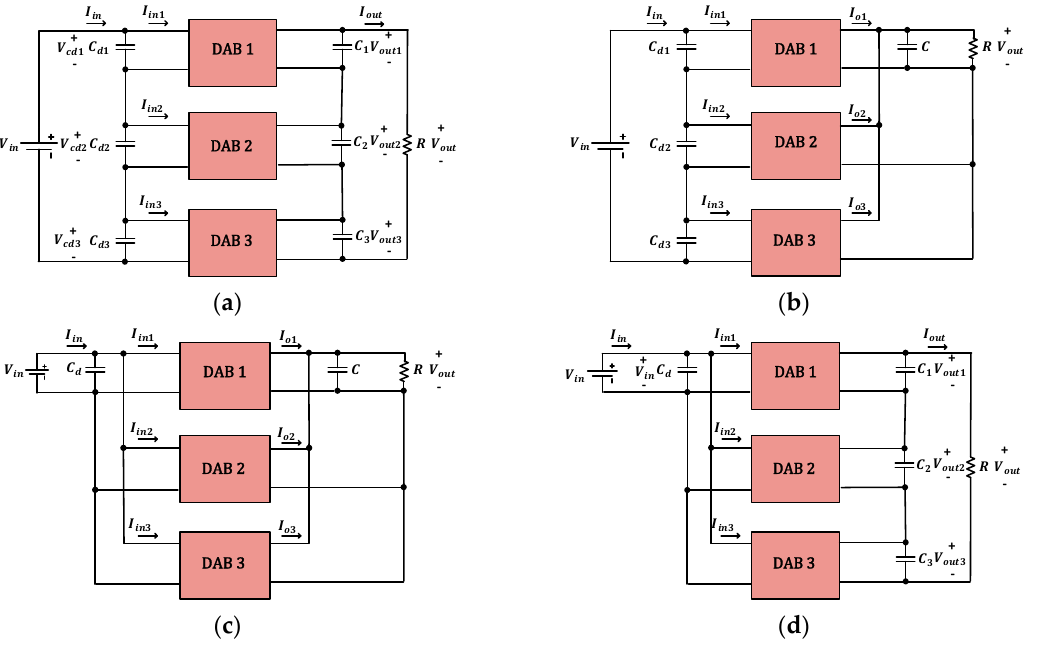
Figure 12. Modular DAB DC-DC converter architecture: ( a ) ISOS; ( b ) ISOP; ( c ) IPOP; ( d ) IPOS.